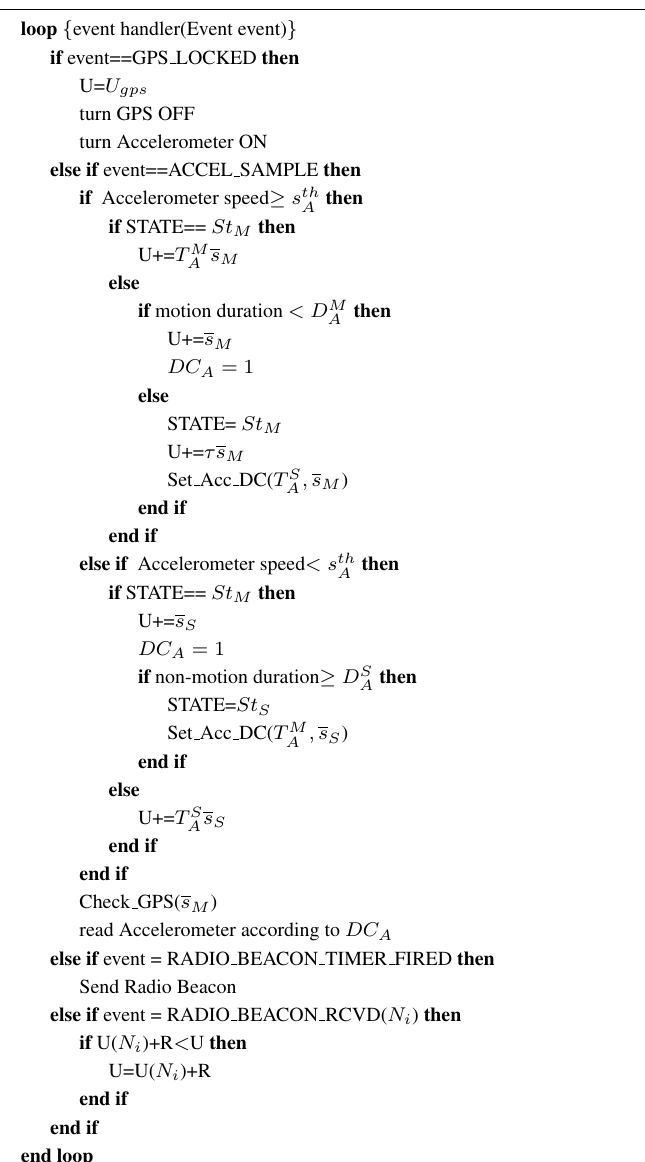
Figure 5. Accelerometer Individual Duty Cycling